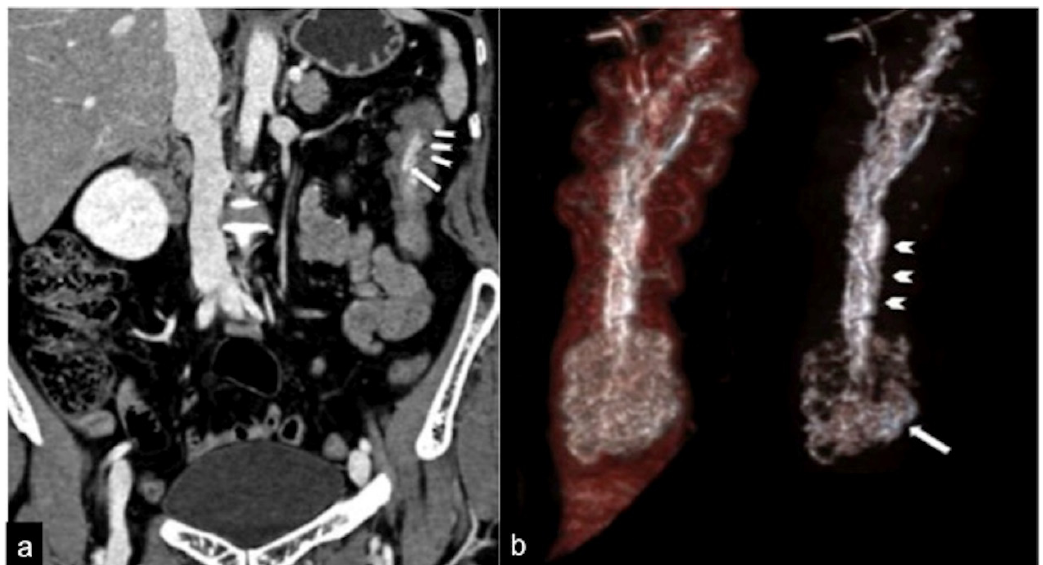
Figure 5. CTA study of a haemorrhagic spot in the ascendant colon. A vascular nidus (arrow) is detected in the arterial phase ( a ); the MIP post-processing with MPR coronal reconstruction facilitates the identification of the vascular malformation (arrow) in order to better define the vascular anatomy for the treatment approach ( b ).